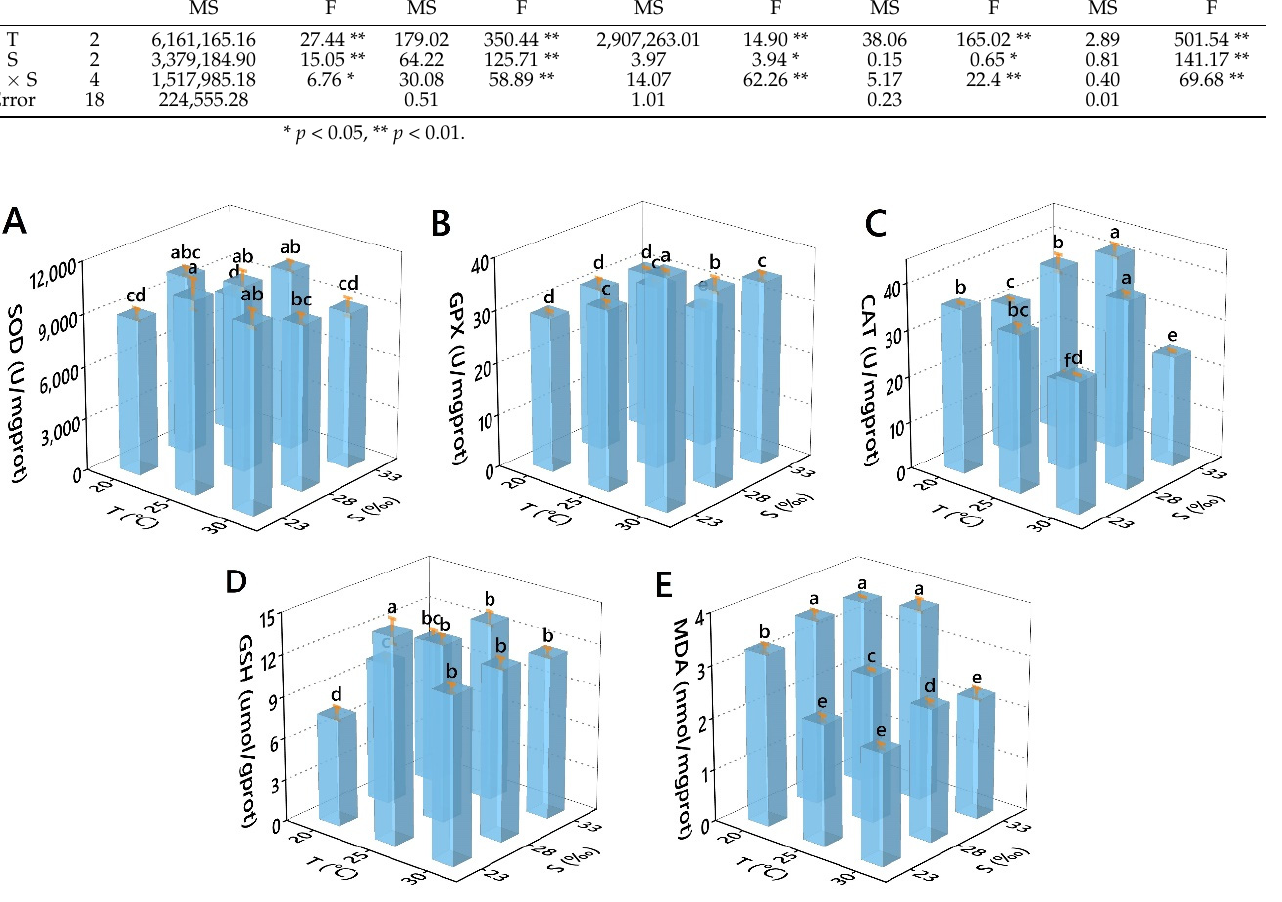
Figure 5. Effects of temperature and salinity on the antioxidant-related indicators. (( A ) SOD; ( B ) GPX; ( C ) CAT; ( D ) GSH; ( E ) MDA) of Perna viridis. Different letters indicate significant differences ( p < 0.05).